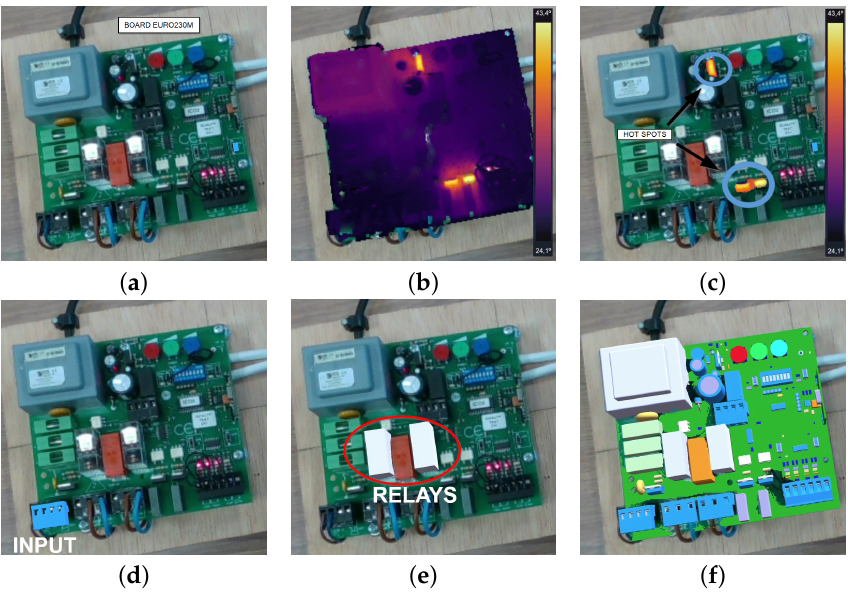
Figure 11. Examples of the AR and IRT display modes for the electronic board: ( a ) RGB view; ( b ) IRT view; ( c ) IRT view—hot spots; ( d ) AR view—Input detection; ( e ) AR view—Relays detection; and ( f ) AR view—Board